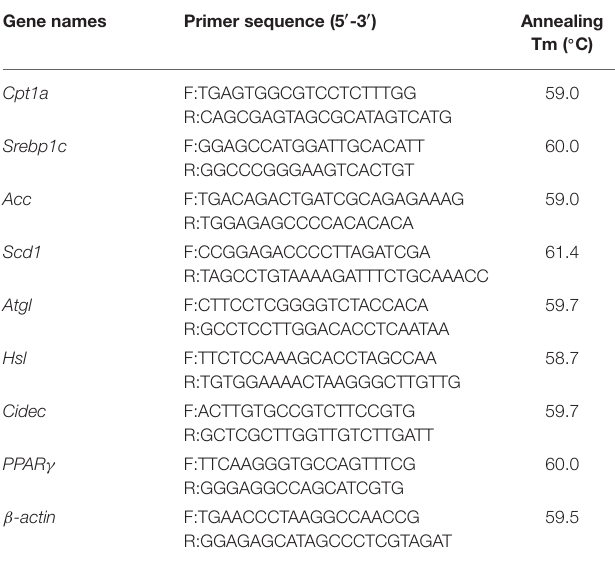
TABLE 1 | Primer list for fluorescent quantitative